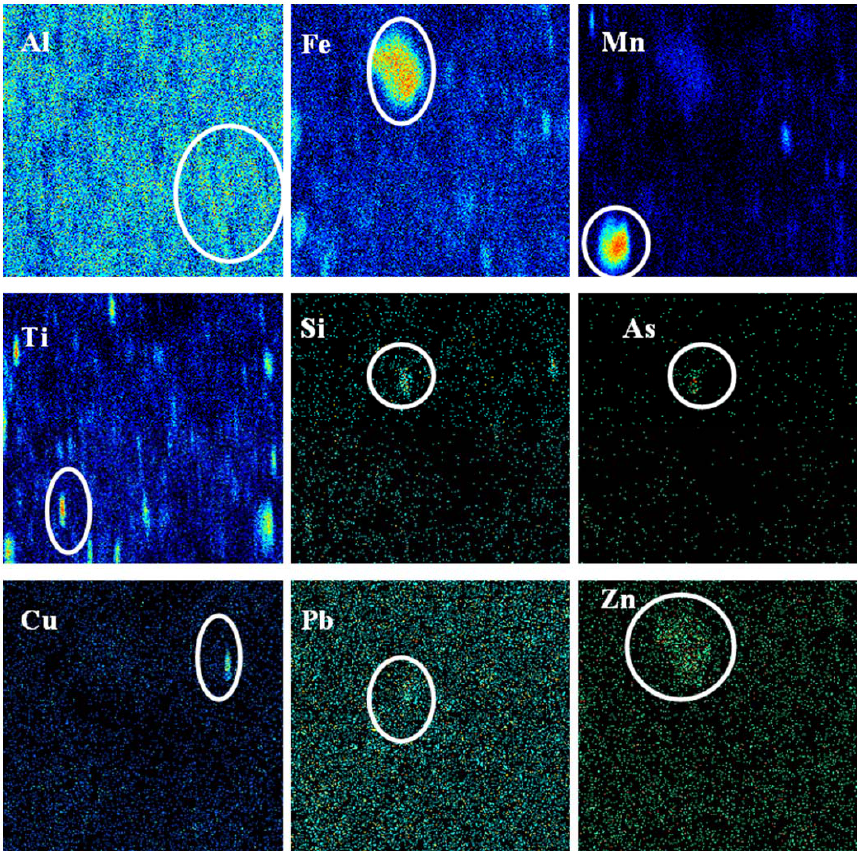
Figure 7. Compositional mapping of major and trace elements by means of microPIXE (sample